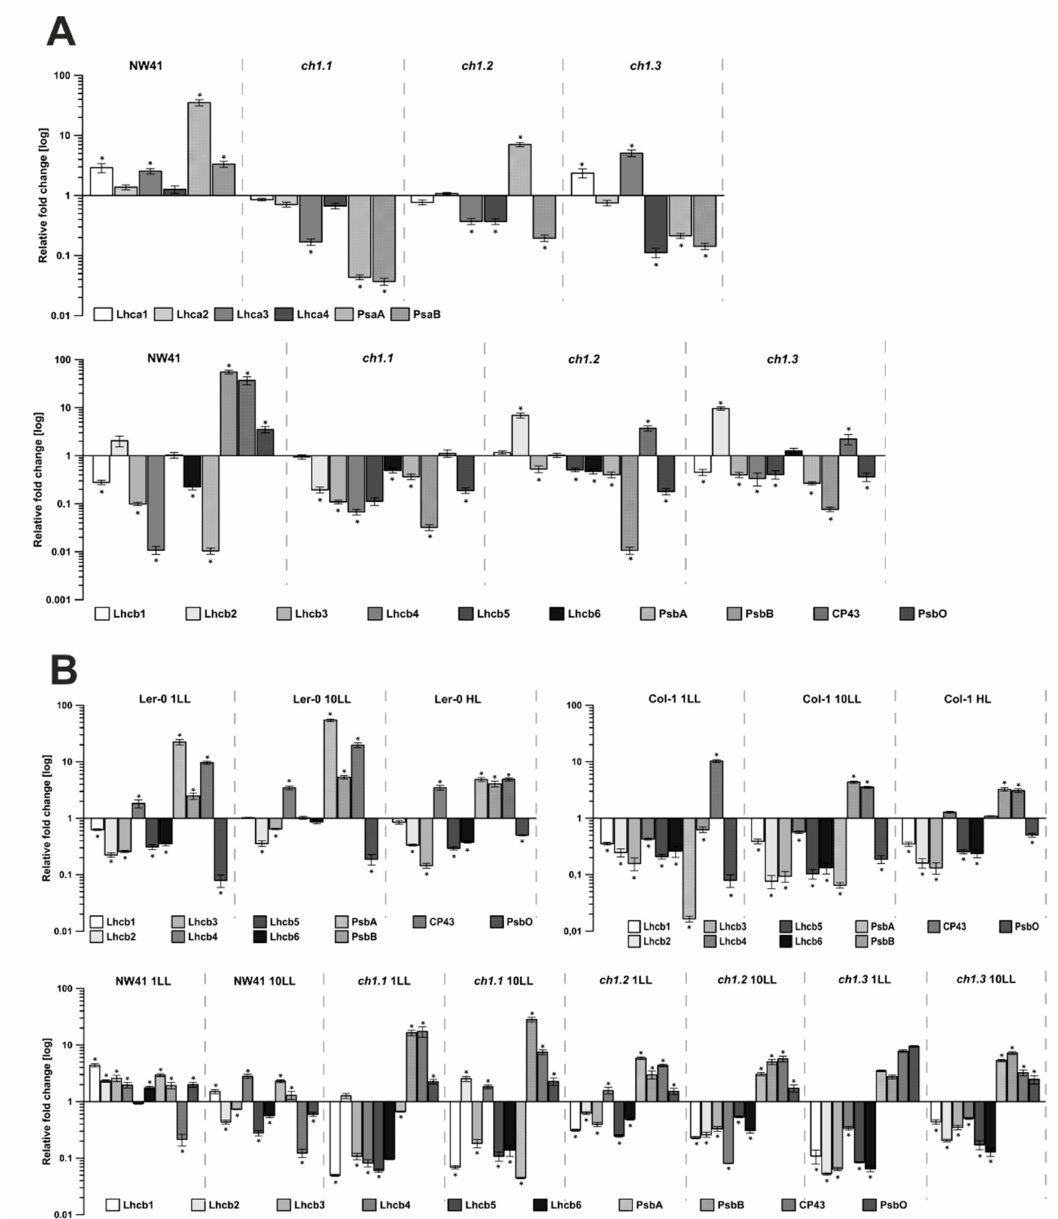
Figure 4. Relative mRNA levels of genes corresponding to antenna and core proteins of PSI and PSII: ( A )—in reference to the corresponding ecotype in NL (normal light) conditions; ( B )—in reference to normal growth conditions (NL) of every analyzed Arabidopsis plant in different stress conditions (1LL, 10LL, HL) for PSII genes. LL—low-light conditions (1, 10—after 1st and 10th day of treatment), HL—high-light conditions. The data are mean values ± SD from 3–4 indepen- dent experiments; results marked with an asterisk differ significantly at p = 0.05 from the corresponding ecotype/plant in NL